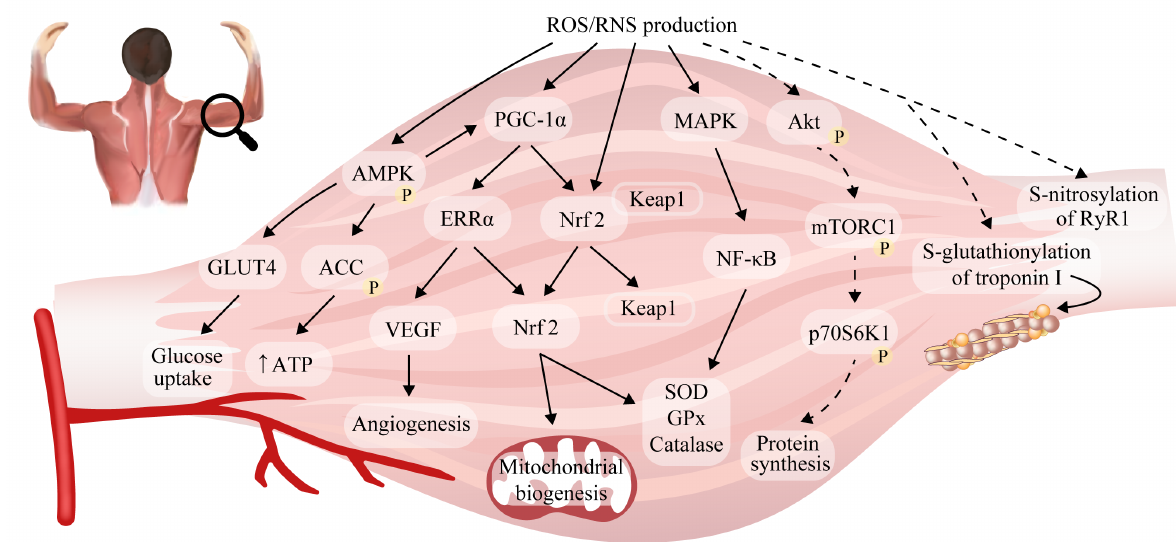
Figure 2. Redox-regulated signaling pathways in muscle adaptations to exercise. During endurance exercise (solid arrows), ROS/RNS participate in AMPK activation to promote glucose uptake, ATP generation, vascularization, mitochondrial biogenesis, and antioxidant defense (via the PGC - 1α pathway). Dashed arrows indicate mechanisms that dominate in response to resistance exercise in fast-twitch fibers. ROS /RNS trigger post - translational modifications in ryanodine receptor (RyR1) and troponin I to increase ongoing force production. The long-term effect is the stimulation of mTORC1-p70S6K1 signaling to orchestrate overload-induced muscle hypertrophy. Abbreviations: ACC, acetyl-CoA carboxylase; AMPK, AMP- activated protein kinase; ERRα, estrogen -related re- ceptor α; Keap1, Kelch - like ECH -associated protein 1; MAPK, mitogen- activated protein kinase; mTORC1, mammalian target of rapamycin 1; NF - κB, nuclear factor - kappa B; Nrf2, nuclear factor erythroid 2- related factor 2; p70S6K1, p70 ribosomal protein subunit 6 kinase 1; RyR1, ryanodine receptor 1; VEGF, vascular endothelial growth factor.